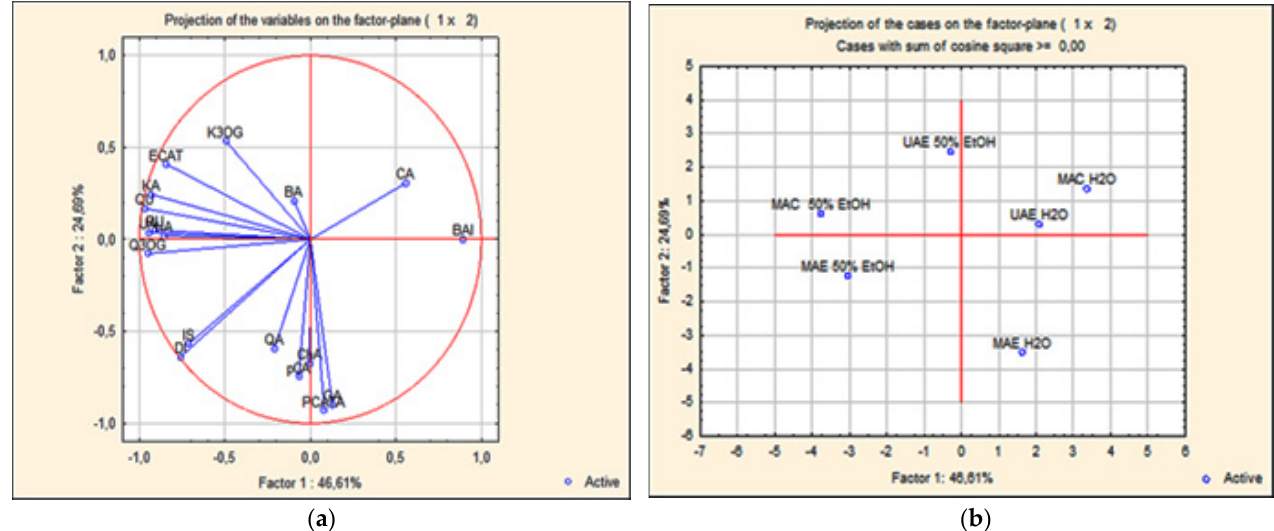
Figure 2. Principal component analysis of phenolic acids and flavonoids content in fresh fruits of elderberry extracts. ( a ) Distribution of variables on loadings plot; ( b ) distribution of elderberry extracts on scores plot.